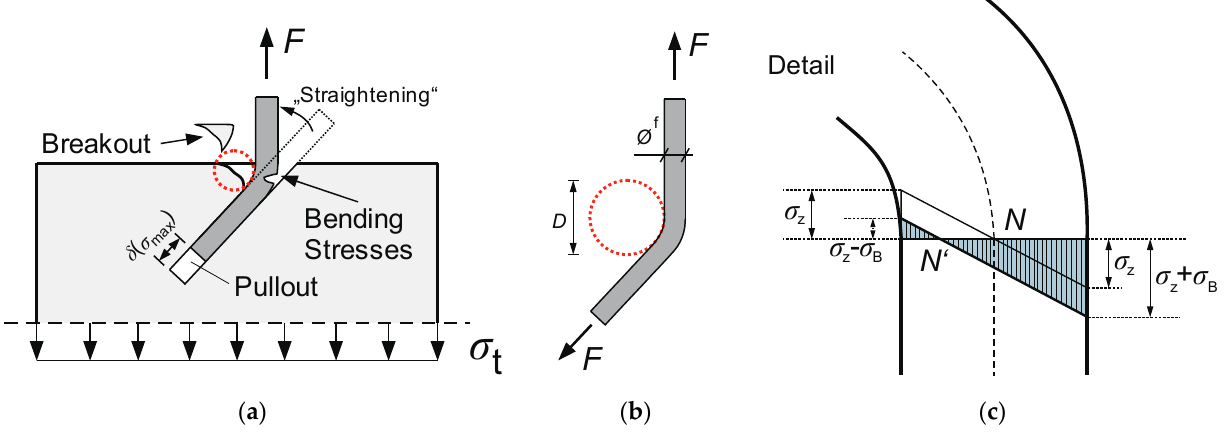
Figure 6. Illustration of bending stress in inclined fibres: ( a ) inclined fibre pullout ( b ) detail of bent fibre ( c ) stress distribution at redirection.